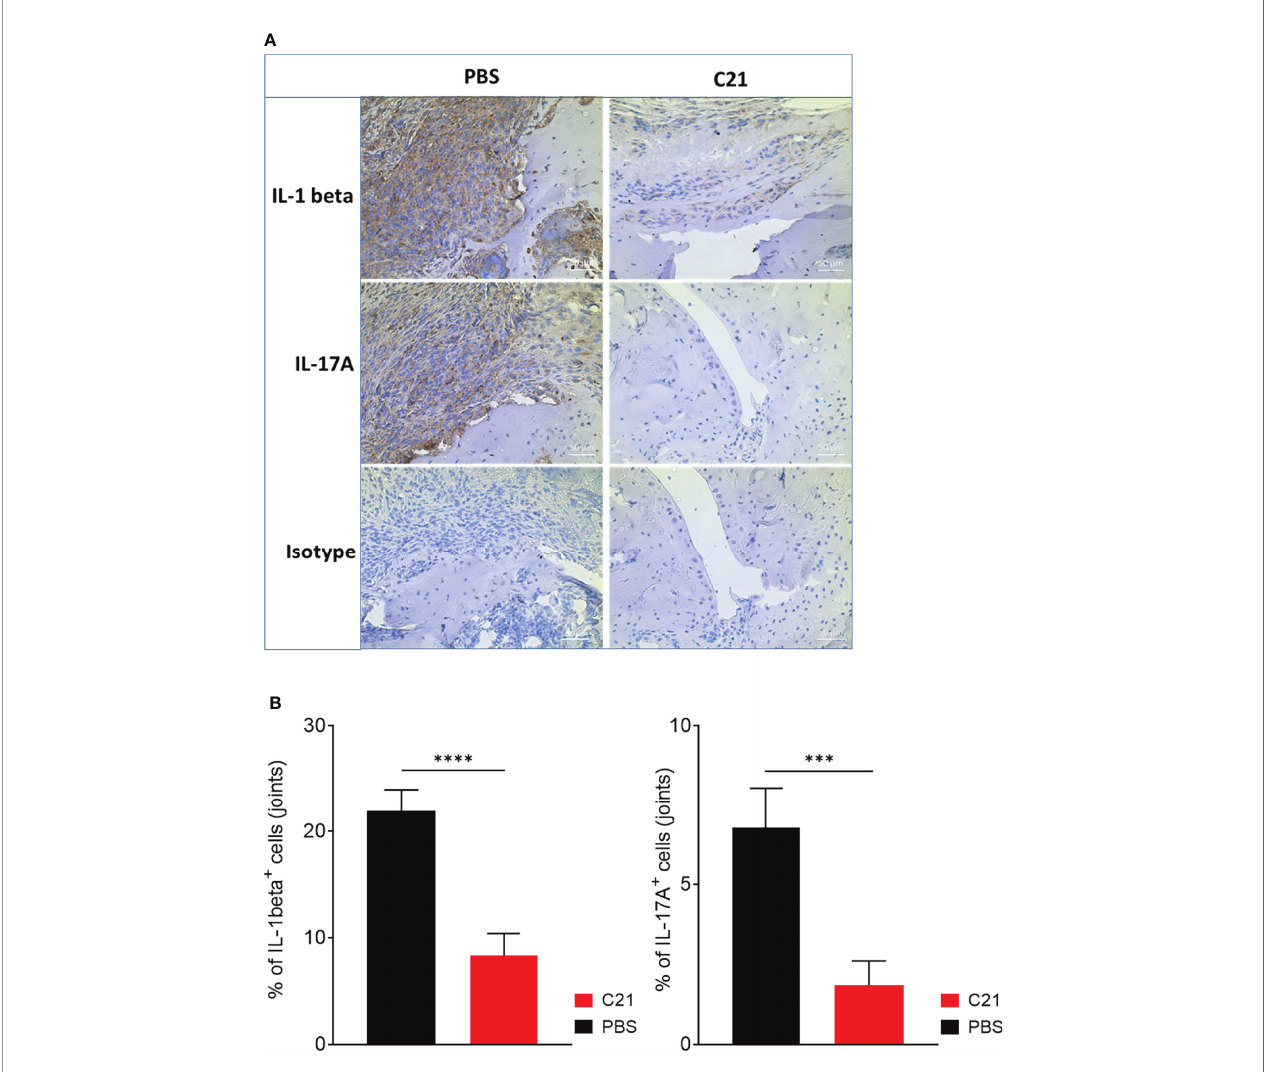
FIGURE 5 | Reduced in fi ltrates of IL-beta and IL17A expressing cells in joints of CIA mice as a consequence of early therapeutic C21 treatment. (A) Paraf fi n- embedded sections of CIA hind paws were immunohistochemically stained for IL-1 beta, IL-17A and isotype control. Positive cells were stained in brown (3,3 ′ - diaminobenzidine 4-HCl, DAB). Hematoxylin (blue) was used for counterstaining. Representative images are shown. Original magni fi cation 20x. (B) Quanti fi cation of IL-1 beta and IL-17A stained joint sections. Sections of 4 randomly chosen mice of each group from one experiment were used and 3 fi elds per section were analyzed. ***= P < 0.001, P****<0.0001. Values shown are the mean ± SEM. P-values were calculated using the nonparametric Mann – Whitney U